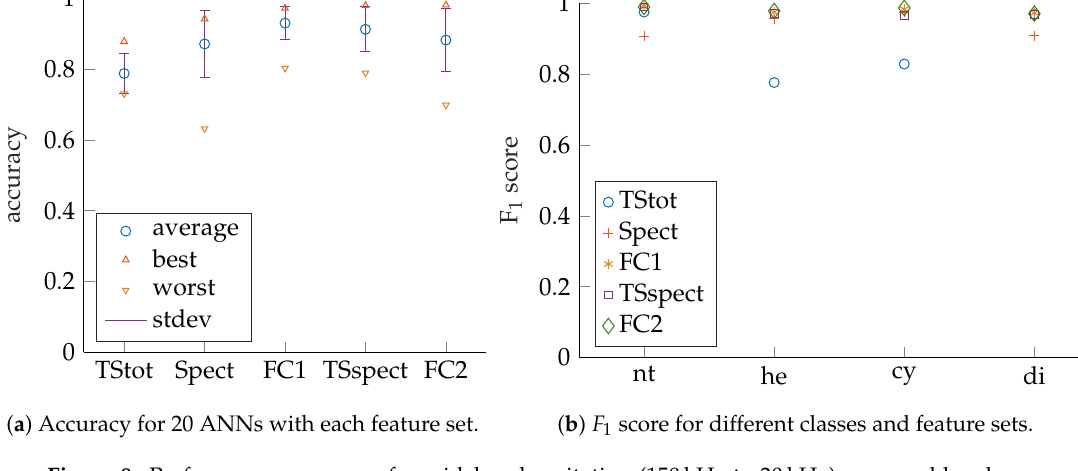
Figure 8. Performance measures for wideband excitation (150kHz to 20kHz); grouped by shapes. Compare also Tables A3 and A4 in the Appendix